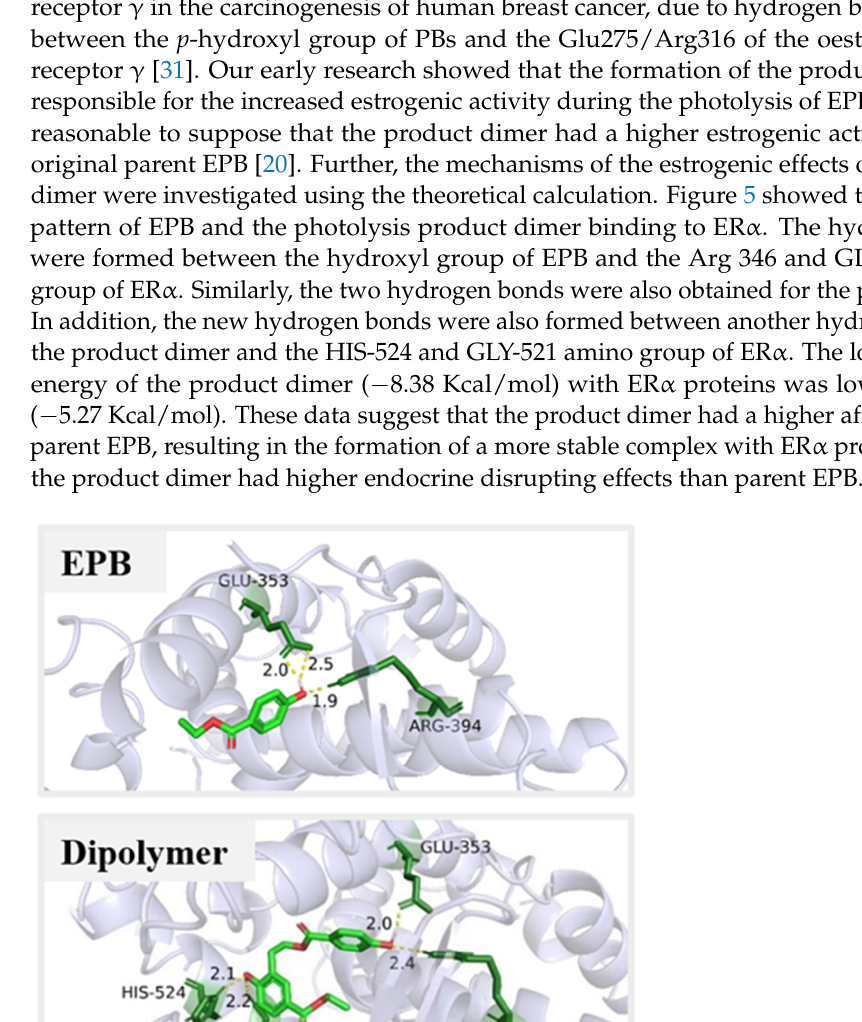
Table 3. Probability ( p ) value of health effects. Blood